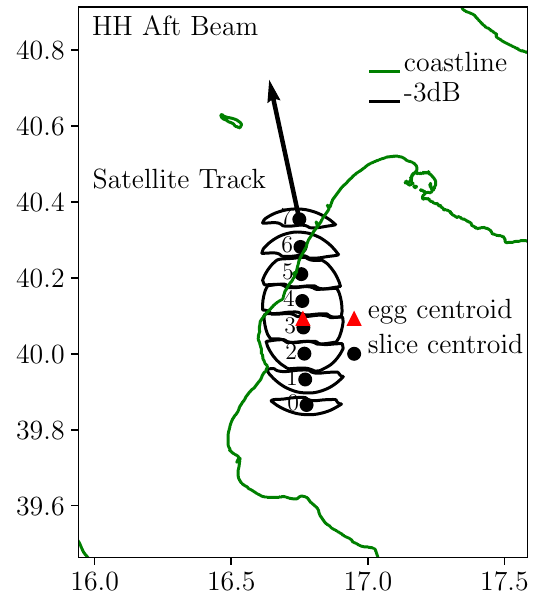
Figure 2. Example of SeaWinds inner-beam aft egg in a coastal region of southern Italy, in the Mediter- ranean basin, acquired with an antenna azimuth angle equal to spatial response function are depicted with black solid lines. The slice index of each slice is reported into the curves on a 0-based numbering. The string HH stands for